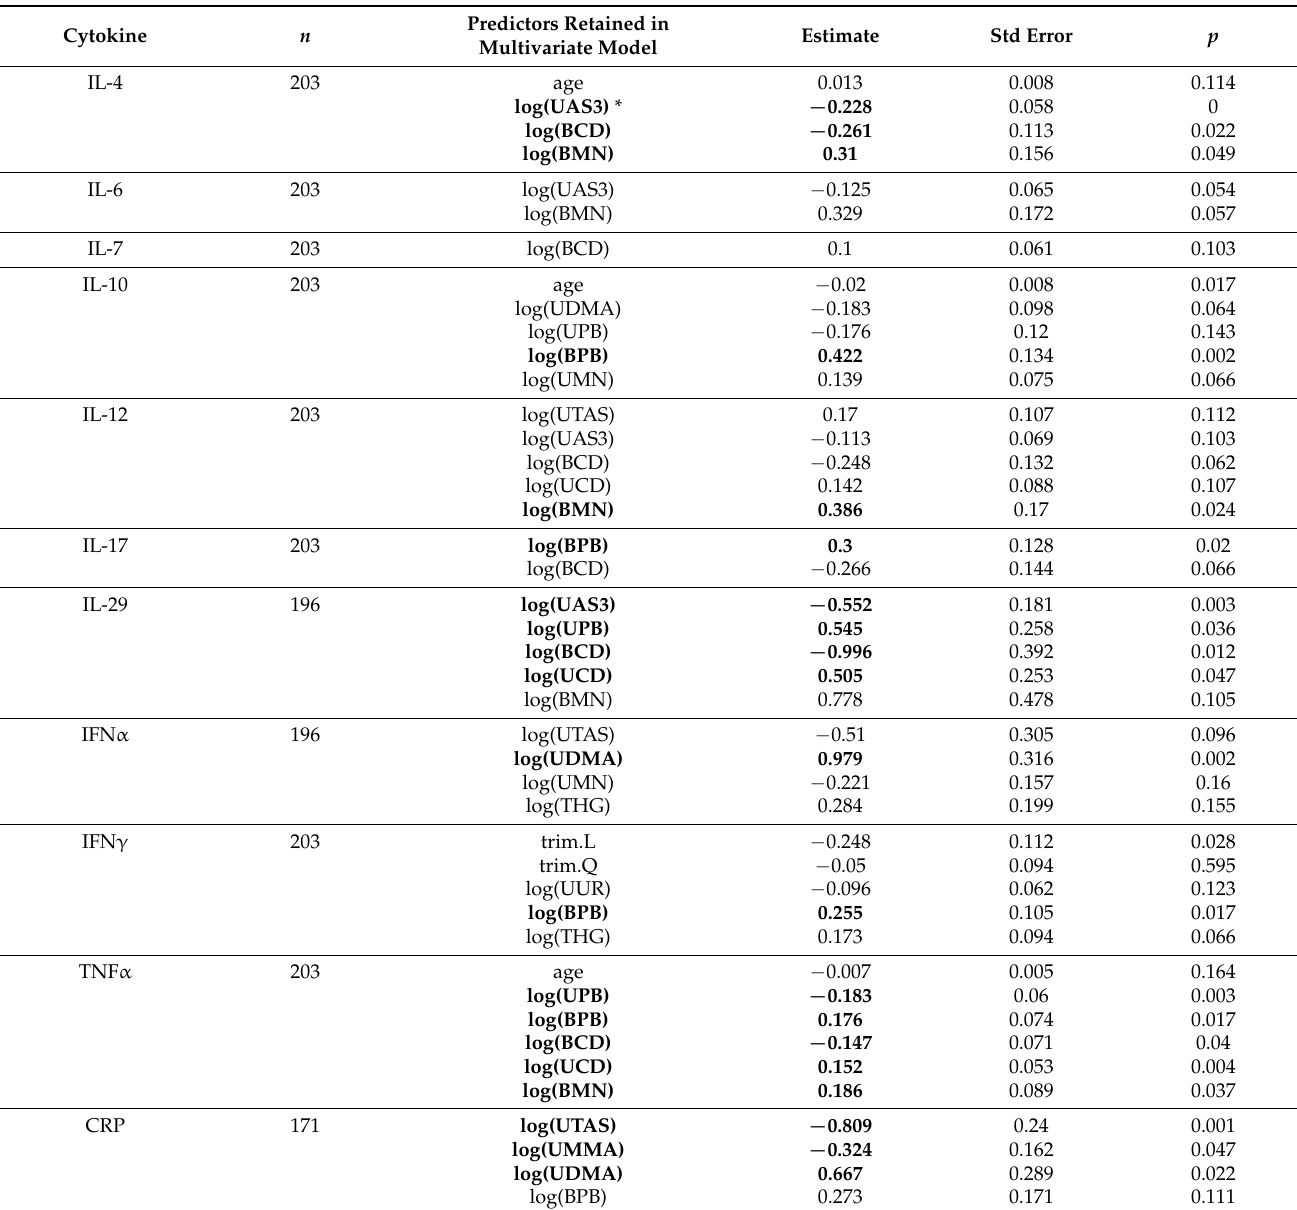
Table 4. Summary of final multivariable models of the relationship between biomonitored metals and metalloids (UUR, UTAS, AsIII, DMA, and MMA, BPB, UPB, BMN, UMN, THG) and cytokines after variable